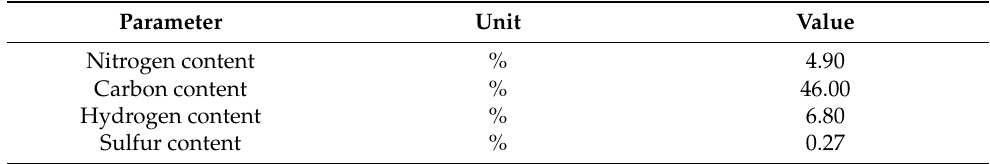
Table 10. Biomass fuel elemental analysis